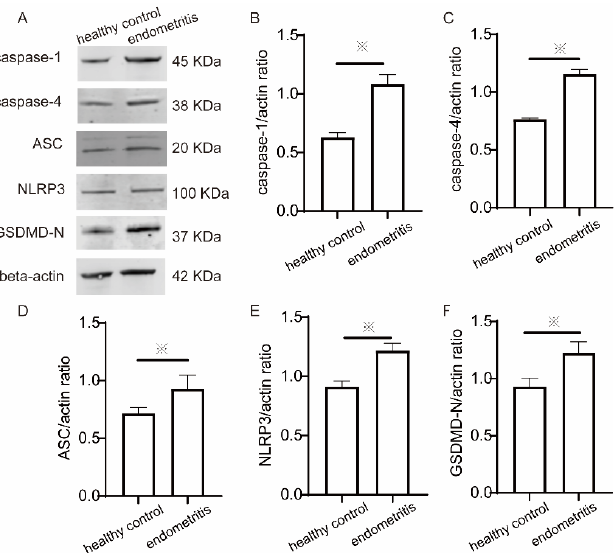
Figure 5. Expression of caspase-1, caspase-4, ASC, GSDMD-N, and NLRP3 in endometrial tissues was detected using Western blot. ( A ) The expression blots of pyroptosis-related proteins, including caspase-1, caspase-4, ASC, GSDMD-N, and NLRP3, with varying molecular weights. Western blot analysis of ( B ) caspase-1, ( C ) caspase-4, ( D ) ASC, ( E ) NLRP3, and ( F ) GSDMD-N in the treatment groups. The experiment was conduced with the endometrial tissues of three healthy cows and the endometrial tissues of three cows with endometritis. ※ p < 0.05.